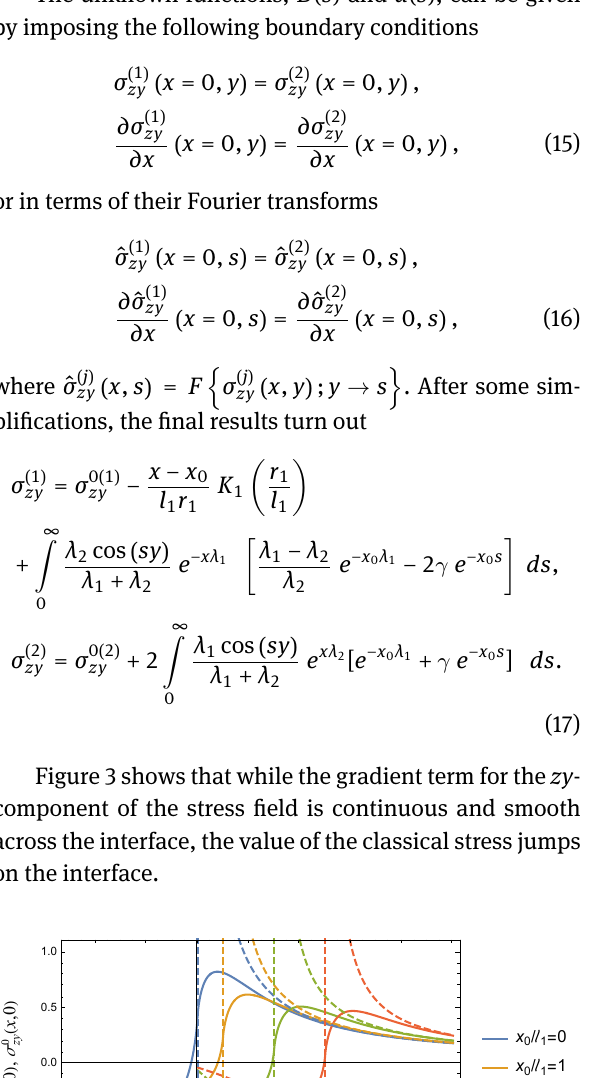
. Solid and 0 / l 1 . 1 b / (2 πl 1 )